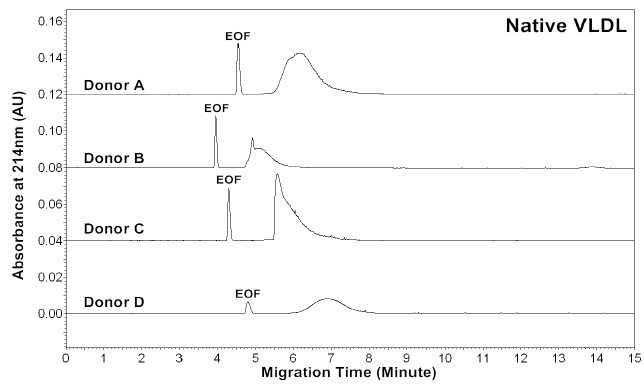
Figure 1. Electropherograms of VLDL particles of four healthy donors. The buffer of VLDL isolated by ultracentrifugation was exchanged from KBr solution to 5 mM sodium phosphate, pH 7.40 using a 100 kDa ultrafiltration filter (MW cut-off: 100,000). For VLDL sample introduction, a pressure of 0.5 psi and a 4 s injection were used. The capillary electrophoresis (CE) separation buffer was 5 mM sodium phosphate, pH 7.40. A voltage of 16 kV was applied and the capillary was kept at 25 °C.